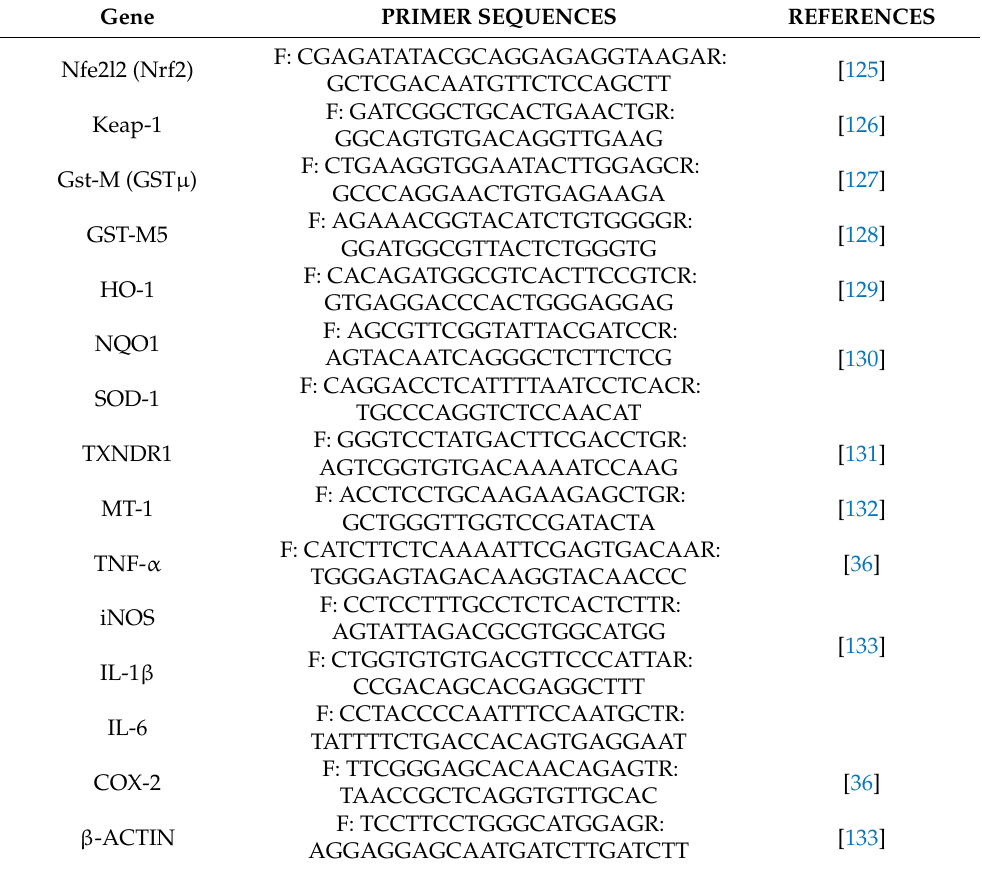
Table 6. Gene primers used for real-time quantitative polymerase chain reaction (qRT-PCR).